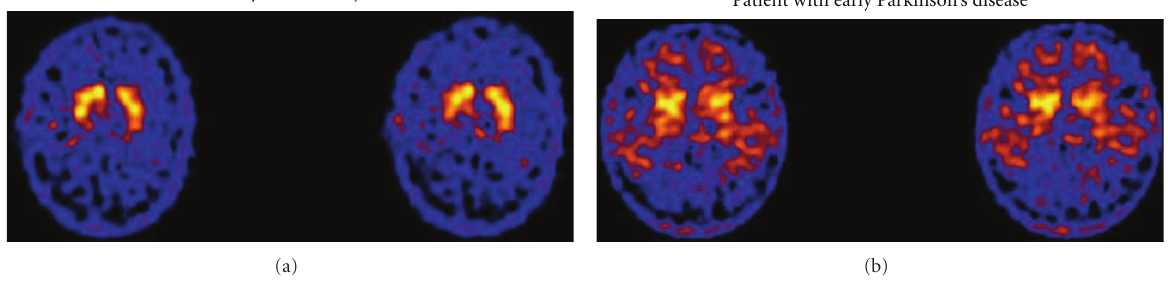
Figure 1: TRODAT-1 SPECT images of a healthy control (a) and a patient with early PD (b). The patient with early PD shows decreased TRODAT-1 uptake in the striatum compared to the control, particularly in the posterior putamen